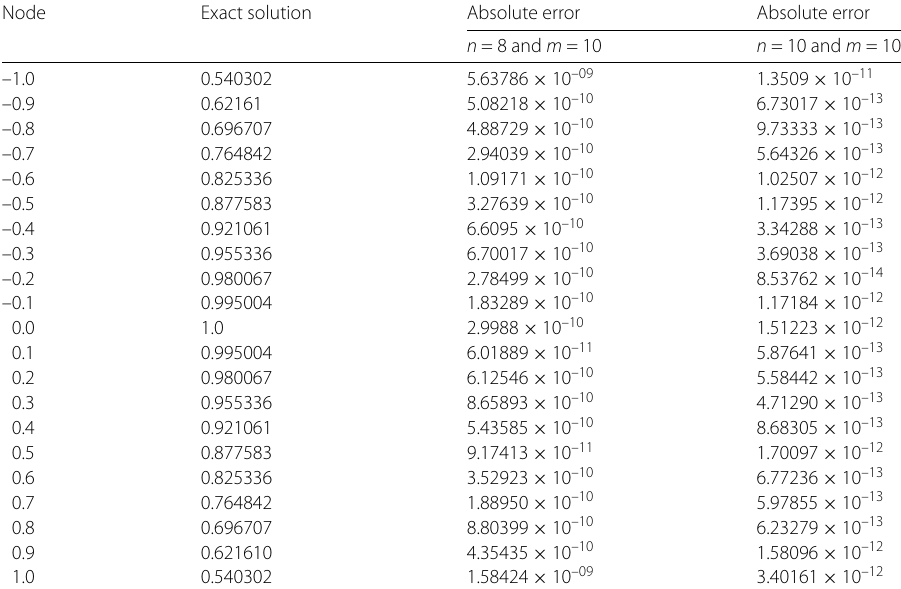
Table 3 Absolute error for Example